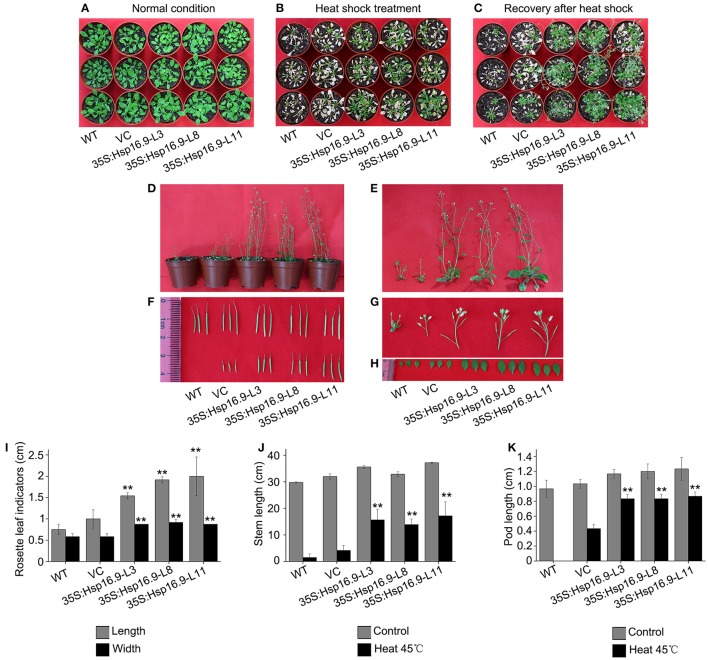
Growth status of WT, VC and MsHsp16.9-overexpressing Arabidopsis plants following 45°C heat stress for 48 h during the reproductive stage. (A) Growth status of control and transgenic plants under normal conditions. (B) Growth status of control and transgenic plants after 45°C heat stress for 48 h. (C) Growth status recovery of control and transgenic plants after 45°C heat stress. (D) Recovery of whole control and transgenic plants. (E–H) Recovery of the stem, silique, flower, and rosette leaf tissue of control and transgenic plants. Survival rate of WT and transgenic plants under normal conditions and after 45°C heat stress for 16 h. (I–K) Length of rosette leaf, stem, and silique indicators in control and transgenic plants. Bars represent the mean ± SE of three independent experiments. **Represent significant differences at p < 0.01 compared with WT plants.